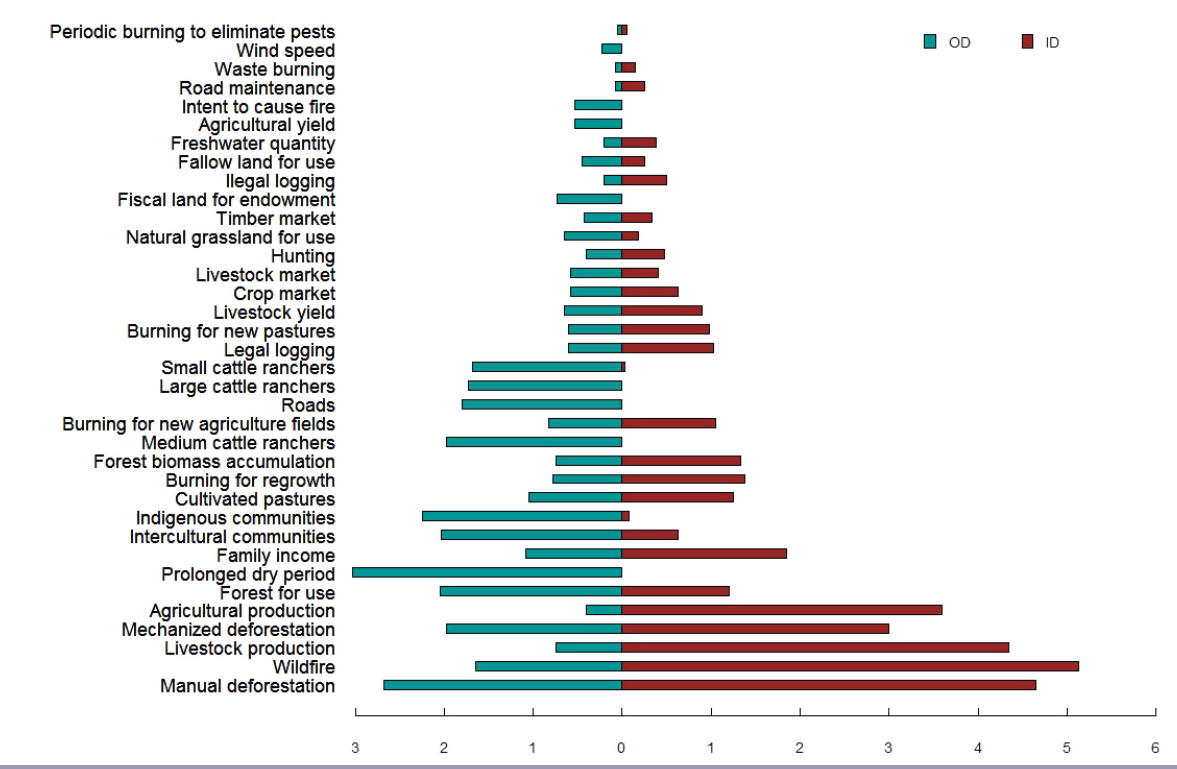
Fig. 4 . Out degree (OD) and in degree (ID) centrality of all variables in the augmented fuzzy cognitive map network. From top to bottom, variables are presented in ascending order based on their degree centrality (sum of OD and ID).